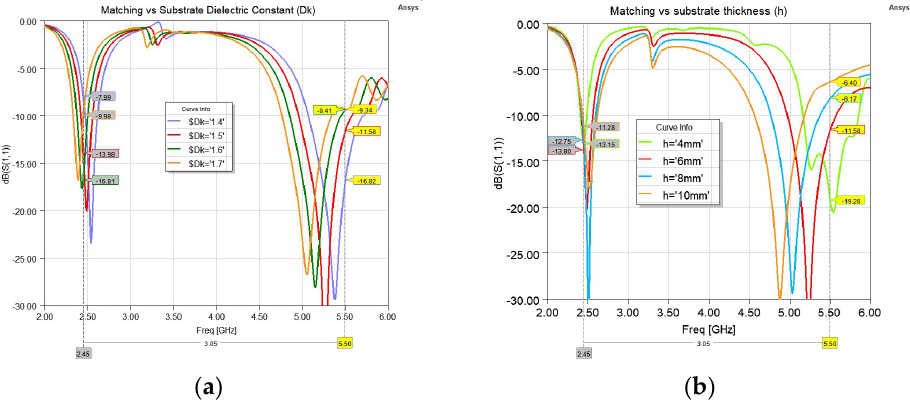
Figure 4. Reflection coefficient variation for various ( a ) Substrate dielectric const (Dk); ( b ) Substrate thicknesses (h) while 𝑎𝑖𝑟 − 𝑔𝑎𝑝 was kept at 2 mm.